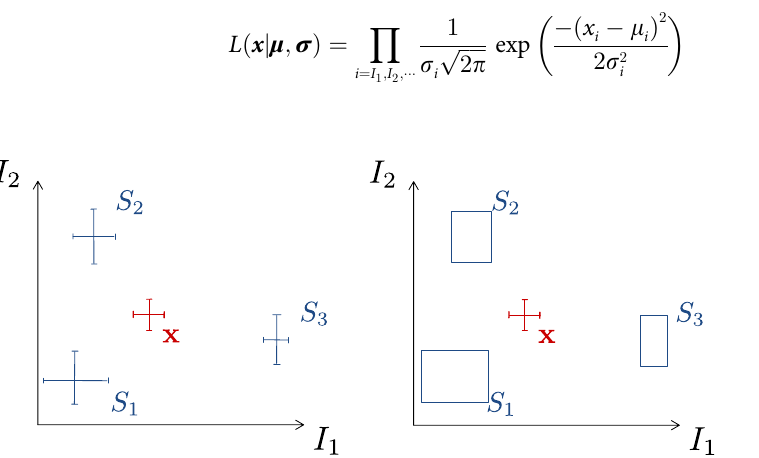
Fig 2. Sketch of a simple 2D case study. I 1 and I 2 span the two dimensions of the calculation and measurement x originates from the mixing of three sources S 1 , S 2 , S 3 . The objective was to calculate the contributions from each source. The left panel shows sources considered as points with uncertainties and the right panel shows sources as rectangles reflecting the range of possible values observed in the sources.